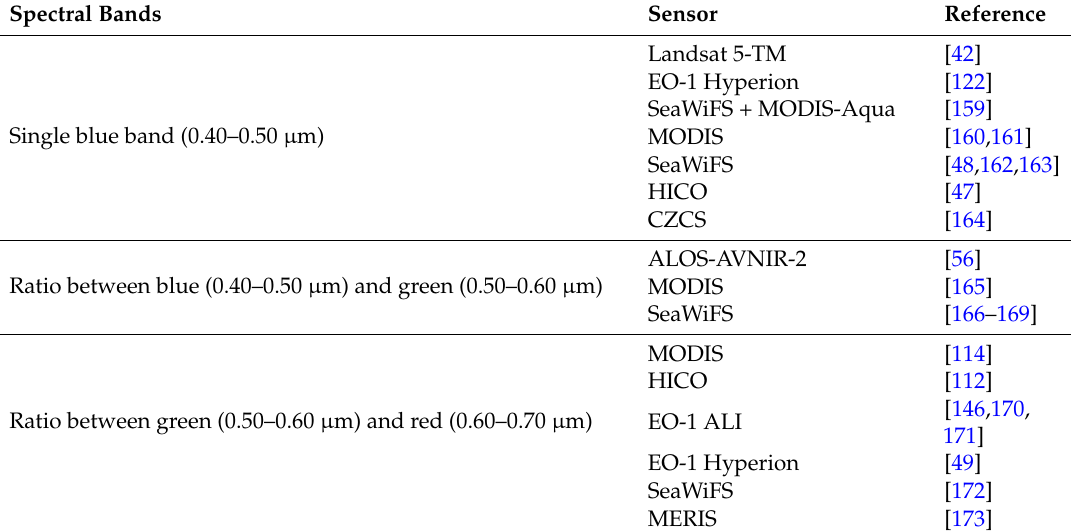
Table 6. Remotely measurements of CDOM using various spectral bands and their ratios. Spectral Bands Sensor